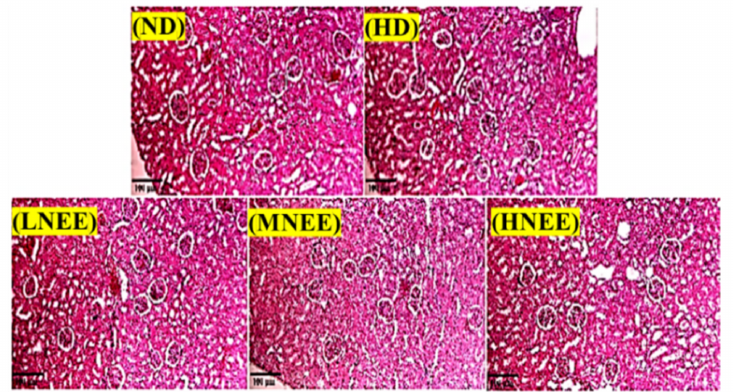
Figure 6. Effects of NEE on kidney histology in high calorie diet–induced obese rats. Observation of obese rat kidney histological tissue slices. Hematoxylin and eosin-stained histological tissue slices were examined using a microscope (400 × ). The group names are defined in Table 2